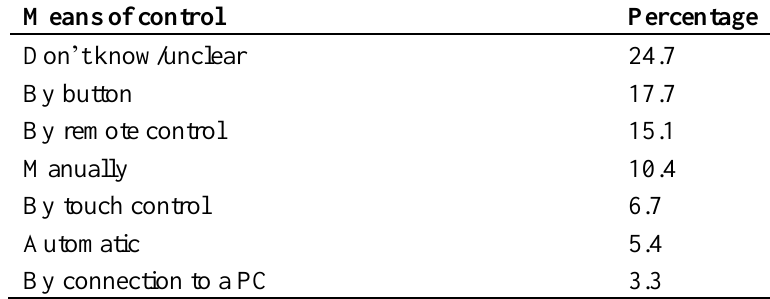
Table 1. Percentage of responders providing a specific response to the question how they would like to control the wearable device. The table only includes answers that had a response rate of 1% or